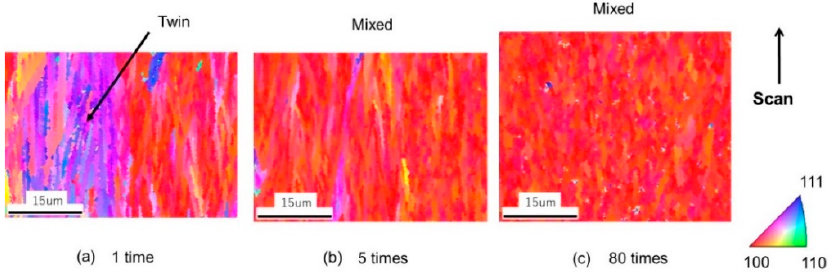
Figure 21. E ff ects of multiple overlapped scans on surface textures. IPF ND maps of ( a ) 1 time,